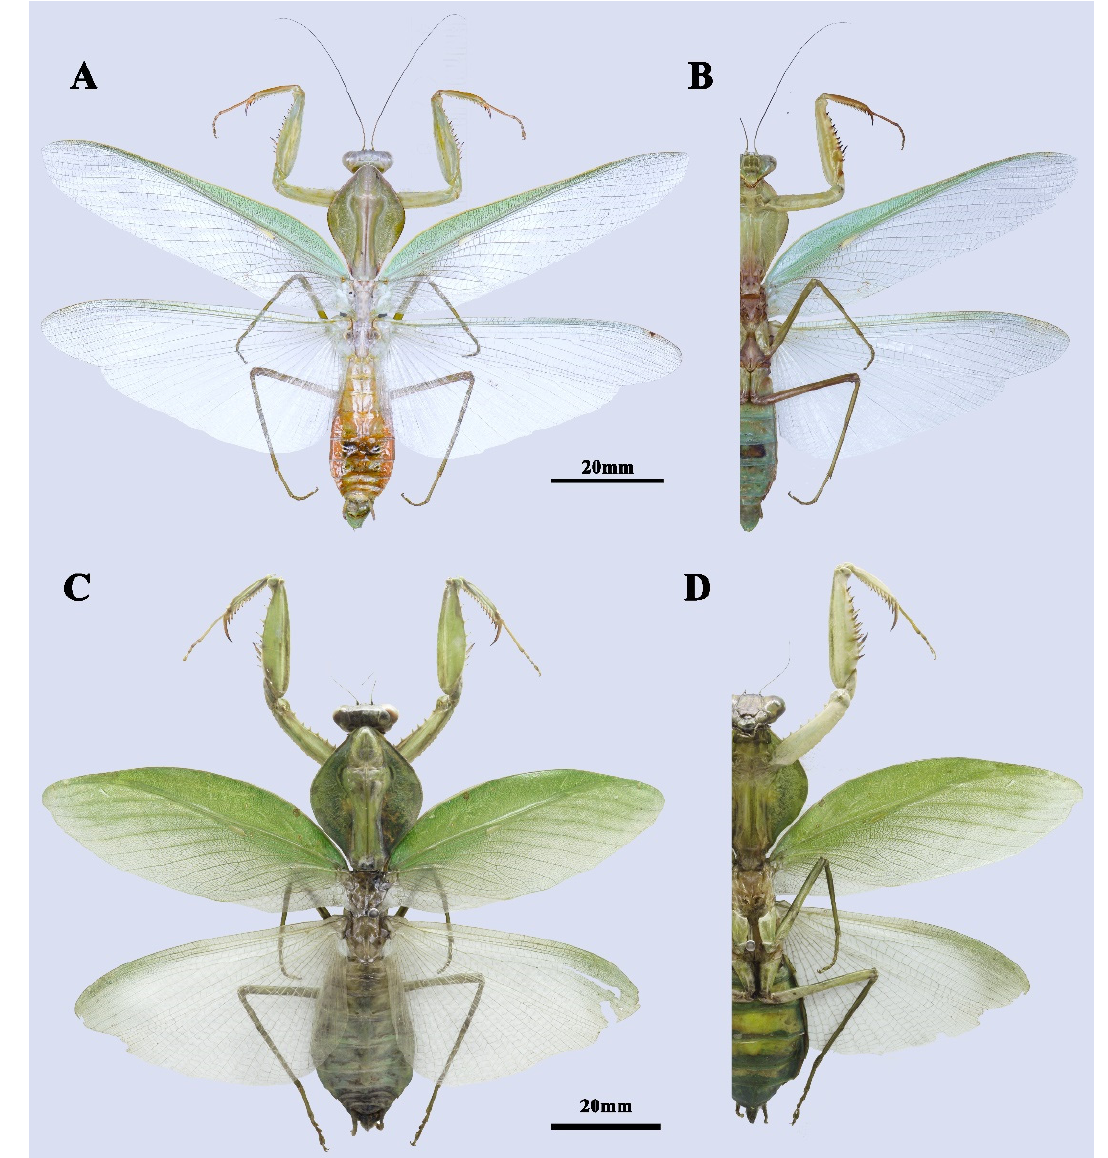
Figure 2. Rhombodera hyalina sp. nov. ( A , B ) Holotype, male. ( A ) Dorsal view. ( B ) Ventral view. ( C , D ) Paratype1, female. ( C ) Dorsal view. ( D ) Ventral view.